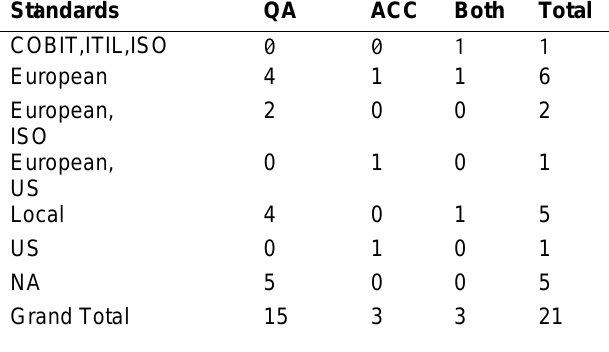
Table 6. Utilized ICTs per